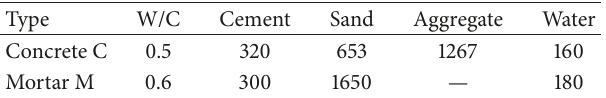
Table 1: Composition of the two types of mixtures used in this project, kg/m 3 .